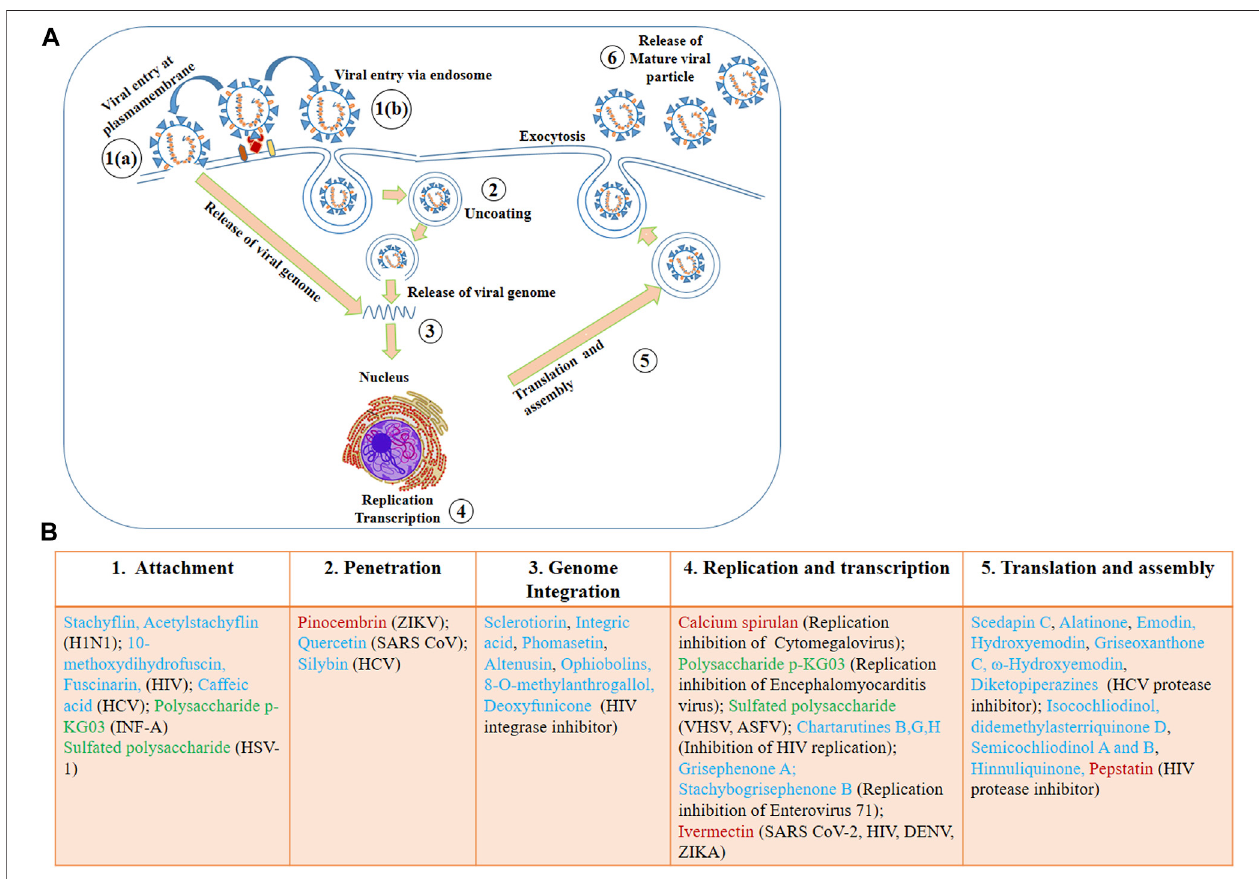
FIGURE 2 | Viral lifecycle (A) and the proposed mode of actions of some of the antiviral microbial secondary metabolites (MSM) (B) listed in this review. The numbers in (A) denote the steps usually targeted by MSM. In (B) , some of the antiviral MSM inhibiting targeted stages of viral lifecycle are listed. Cyan, red and green colors indicate the metabolites isolated from fungi, bacteria and microalgae, respectively. (C) Antiviral drug development strategy based on the viral and host factors.